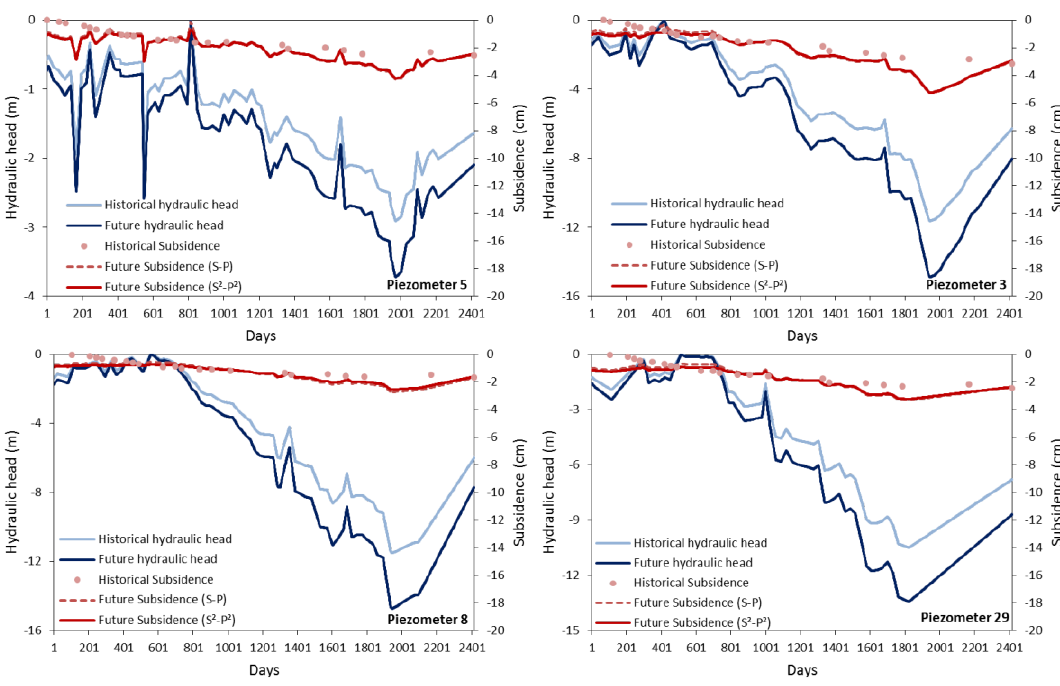
Figure 9. Historical and future subsidence and hydraulic head for the two best linear regression models (S = a × P + b; S² = a × P² + b).